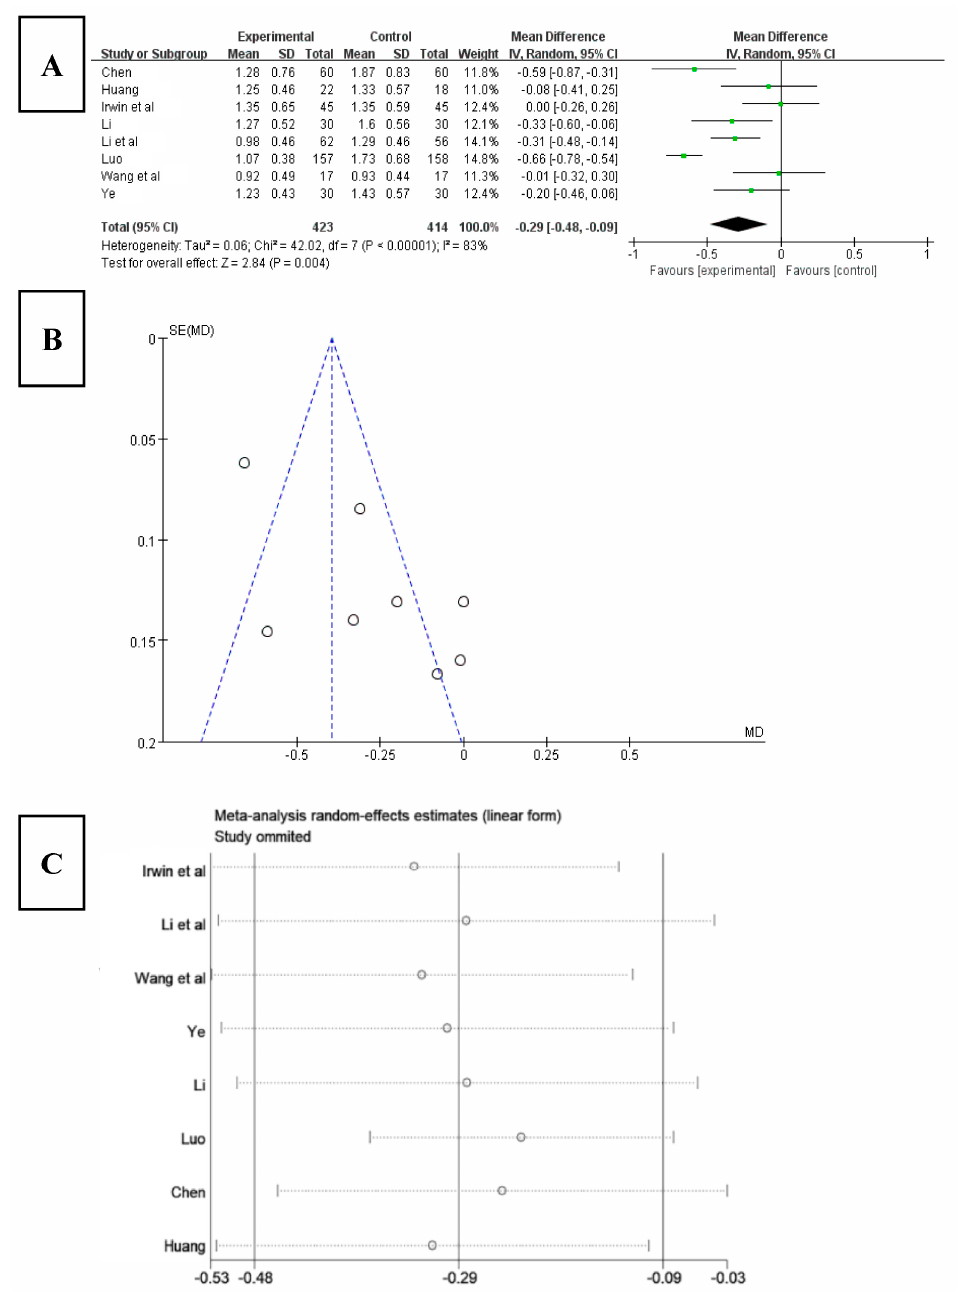
Figure 8. ( A ) Forest plot of sleep disorder effect size. ( B ) Funnel diagram of meta-analysis of sleep disorders. ( C ) Sensitivity analysis of sleep disorder effect size.